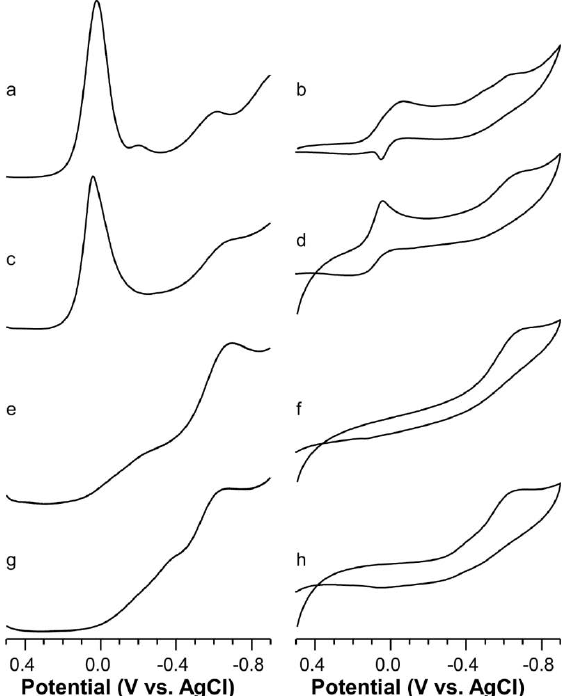
Figure 6. Square wave (left) and cyclic (right) voltammograms of Cu(II)-AcAng1-17 system (C L = 5 × 10 −4 M, M:L 0.9:1, KNO 3 0.1 M) in aqueous solution as function of the pH: ( a , b ) 4.5; ( c , d ) 6.0; ( e , f ) 8.0; ( g , h )